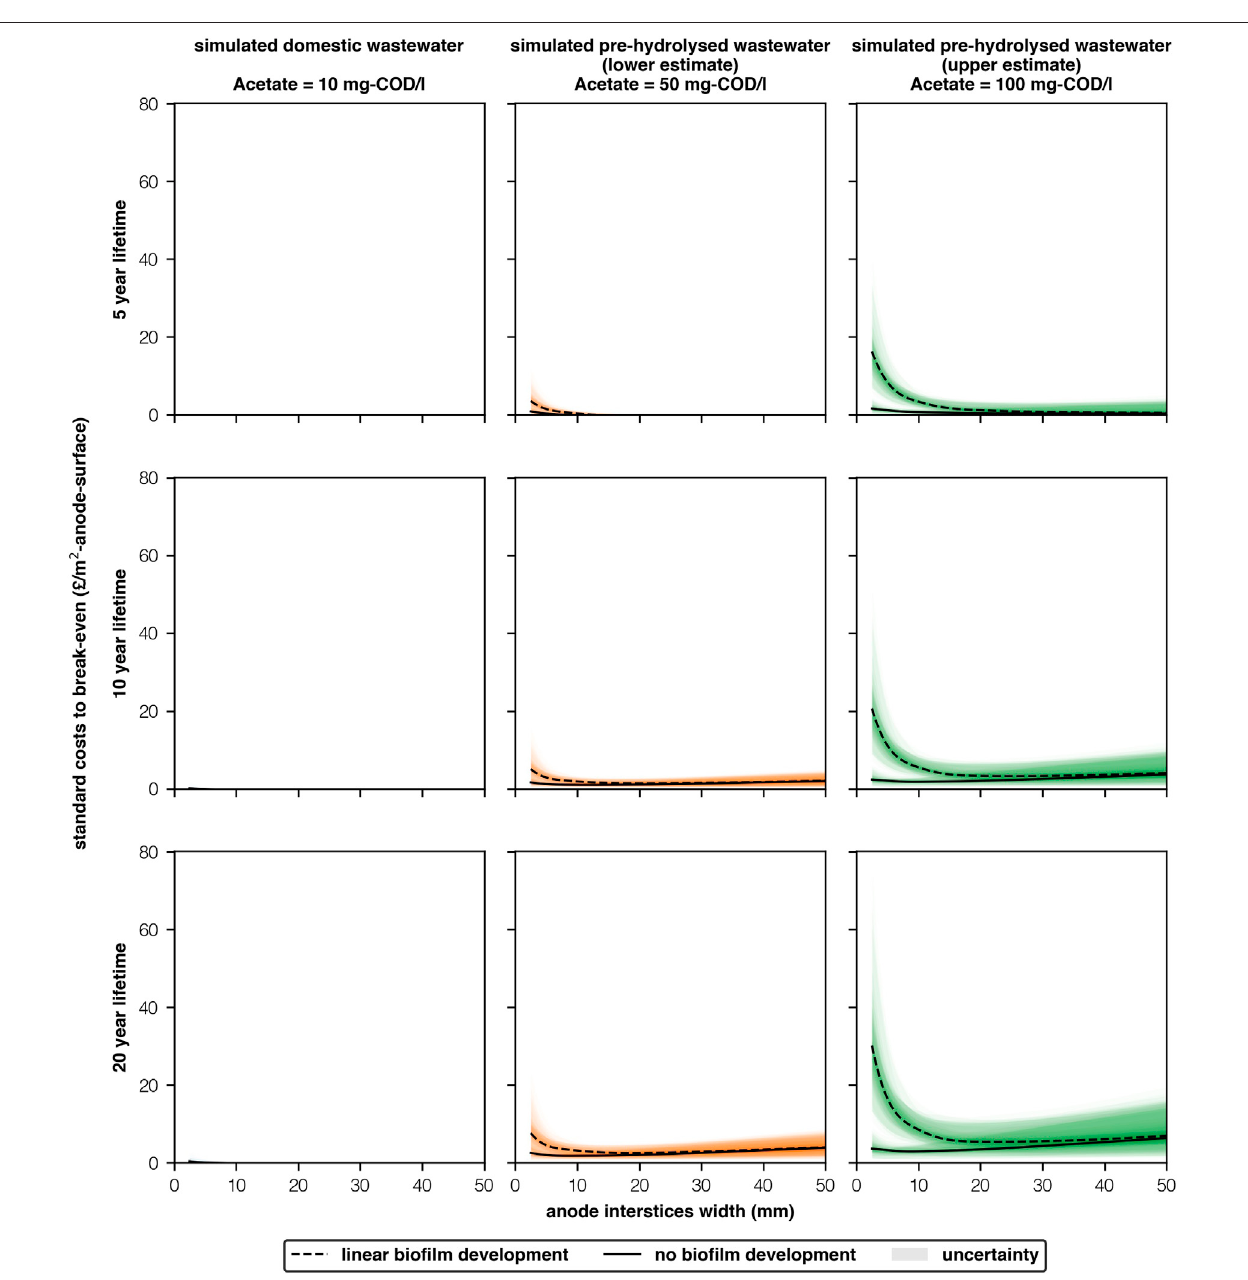
FIGURE 3 | Allowable standard costs (/m 2 -anode) for MECs to break-even with AS treating simulated wastewaters with different acetate concentrations (10- 100 mg-COD/l), anode interstices widths (2.5 – 50 mm) and service life-times (5 – 20 years) [2 columns].